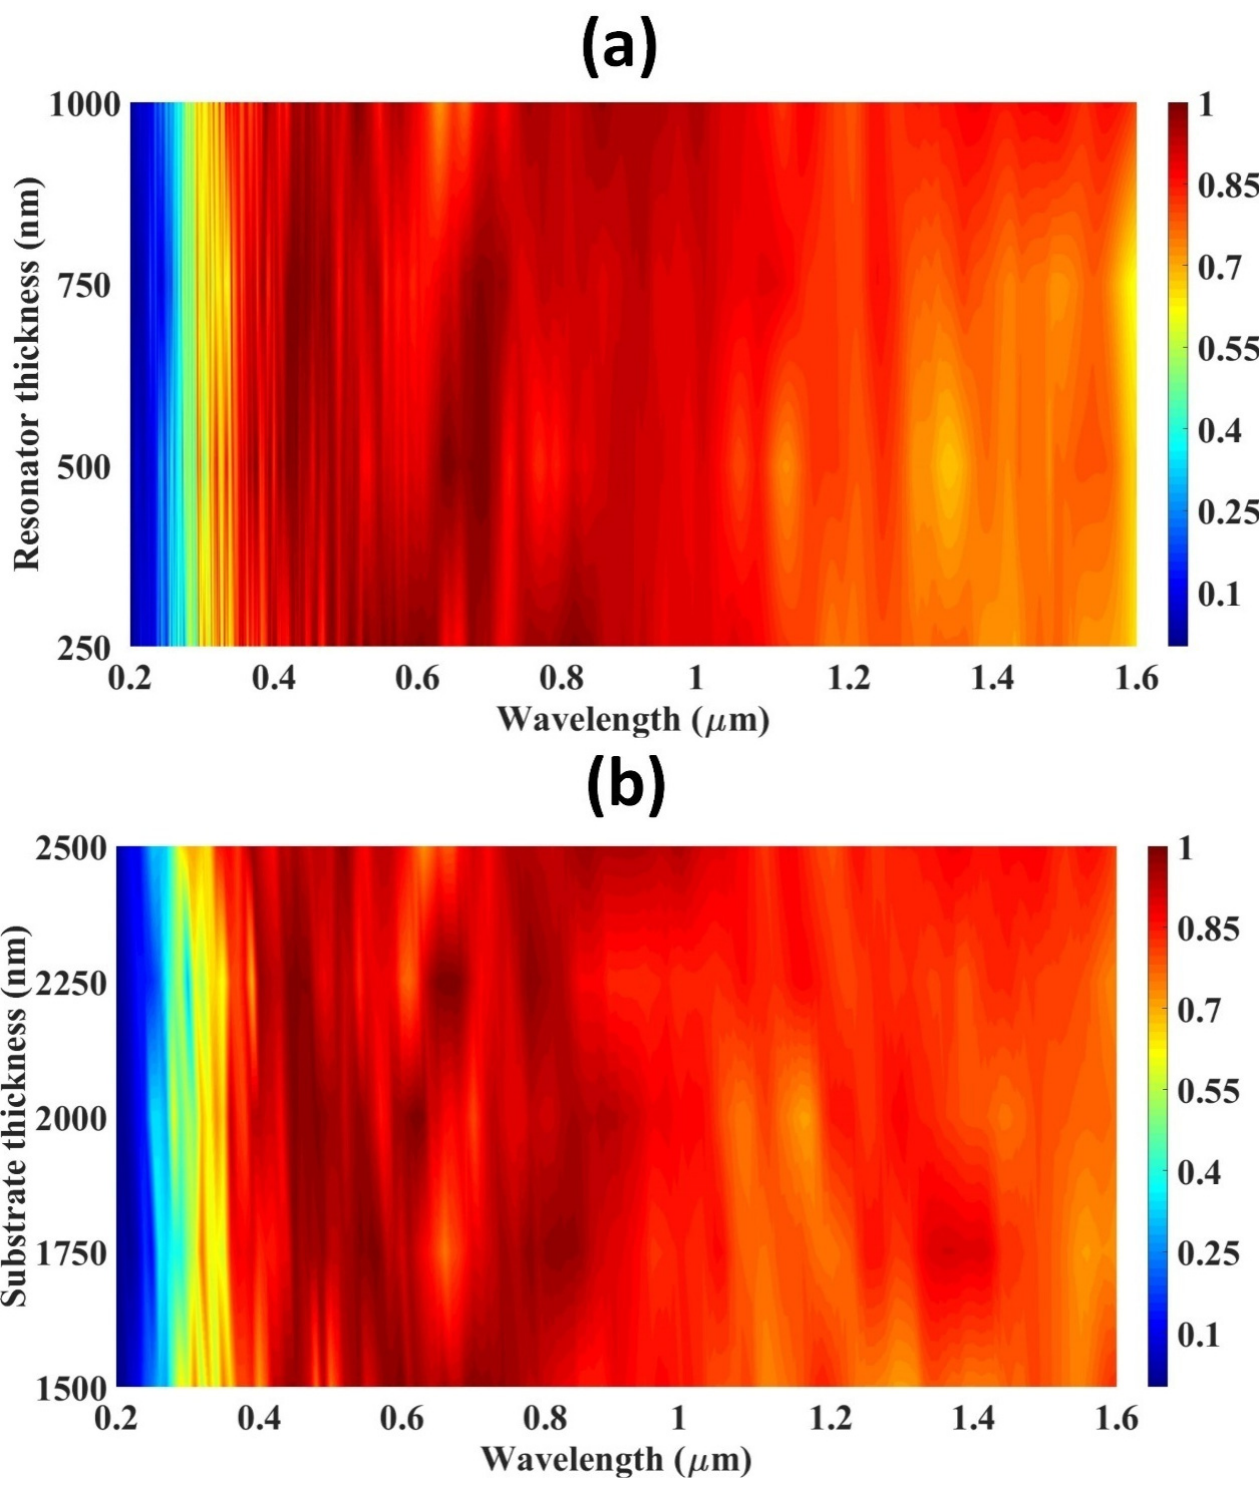
Figure 3. Parameter variation for the 0.2 to 1.6 micrometer spectrum. ( a ) Resonator thickness (nm). ( b ) Substrate thickness (nm). The absorbance increases as the resonator and substrate thicknesses grow. The best value of resonator and substrate thickness is 1000 and 2500 nm, respectively.